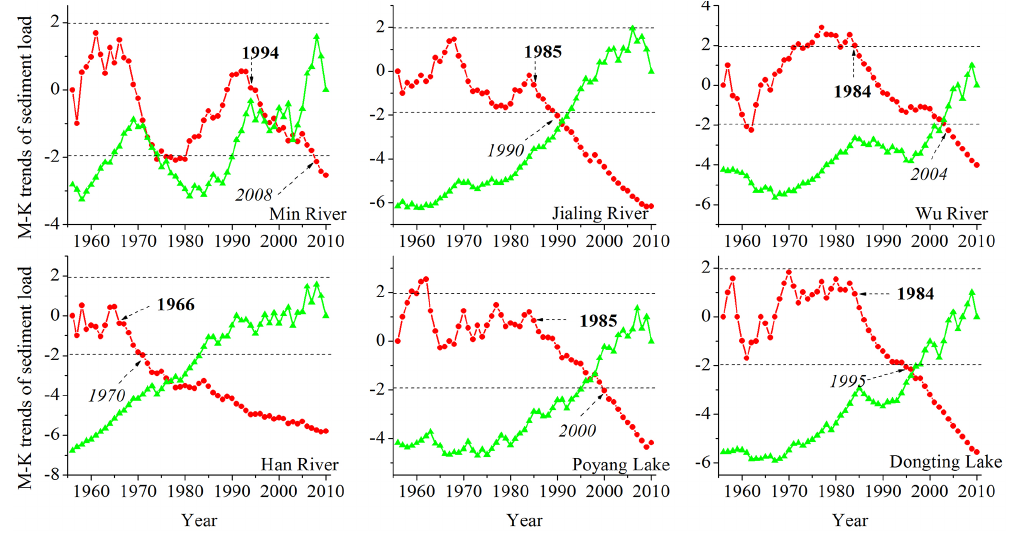
Figure 4. Mann–Kendall trends of the sediment load for the Jinsha, Min, Jialing, Wu, and Han rivers and the Poyang and Dongting lakes systems. The red bullets and green triangles denote C 1 and C 2 , respectively. The bold represents the beginning time of sediment load decreasing, and the italics represent the time when the M–K trends of the sediment load pass the 95% confidence test.